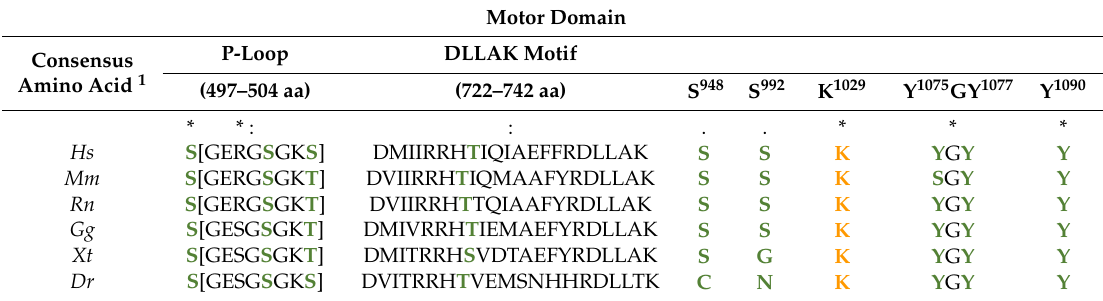
Figure 4. Post-translational prediction of Myo16 motor domain. Sequence analysis was performed using PhosphoSitePlus [71]. The total number of references shows the reliability of the prediction. Green squares indicate the phosphorylation sites while orange circle shows the ubiquitination site. Table 2. Sequence alignment of Myo16 motor domain from different representatives of vertebrate classes in the aspect of post-translational modifications using Clustal-X [72].